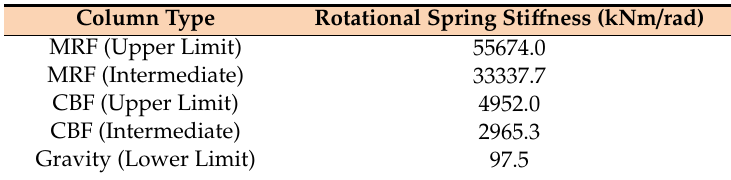
Table 1. Rotational spring sti ff ness values used for base fixity model detailing (all in a range of pinned column